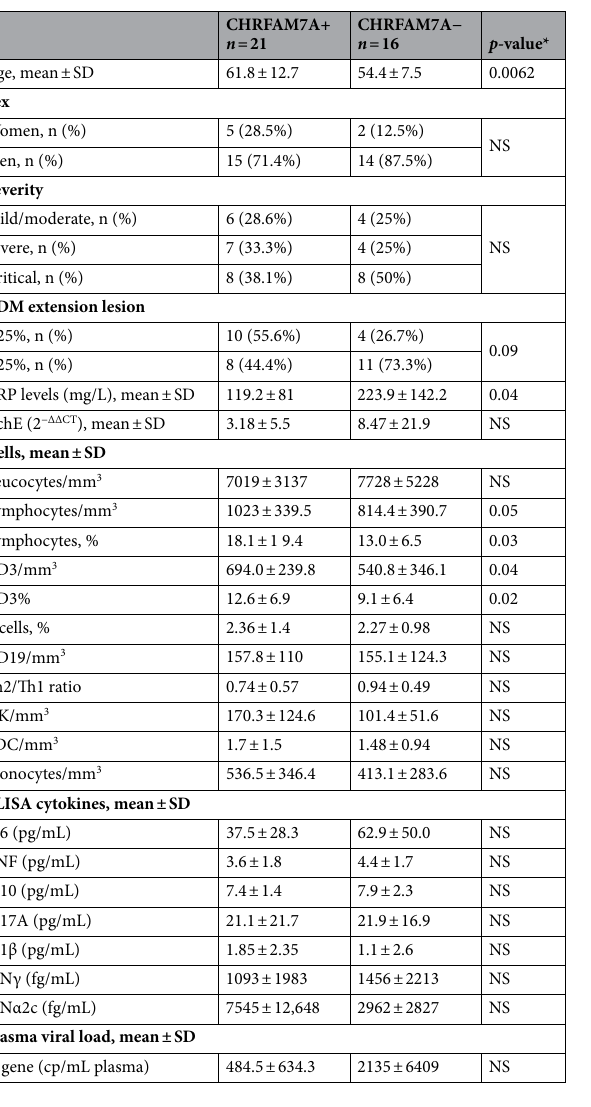
Table 2. Comparison of COVID-19 patients according mRNA expression of CHRFAM7A in whole blood. N number, NS not significant, pg/mL picogram per milliliter, fg/mL femtogram per milliliter, cp/mL copy number per milliliter, pDC peripheric dendritic cells, NK natural killer, IL interleukin, IFNγ interferon gamma, IFNα2c interferon alpha 2c. * p -value were calculated using Mann–Whitney test, and are specified if ≤ 0.1; otherwise NS is